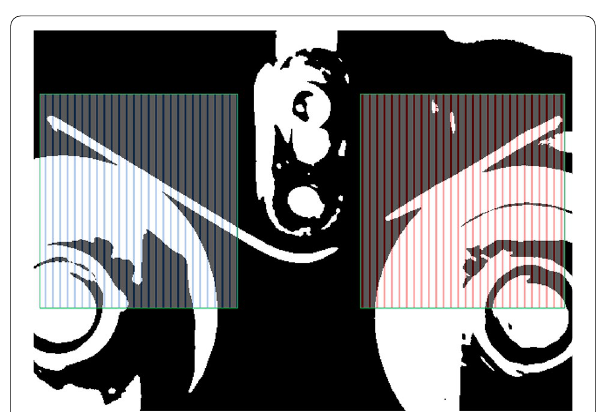
Figure 13 Measurement image to obtain unloaded